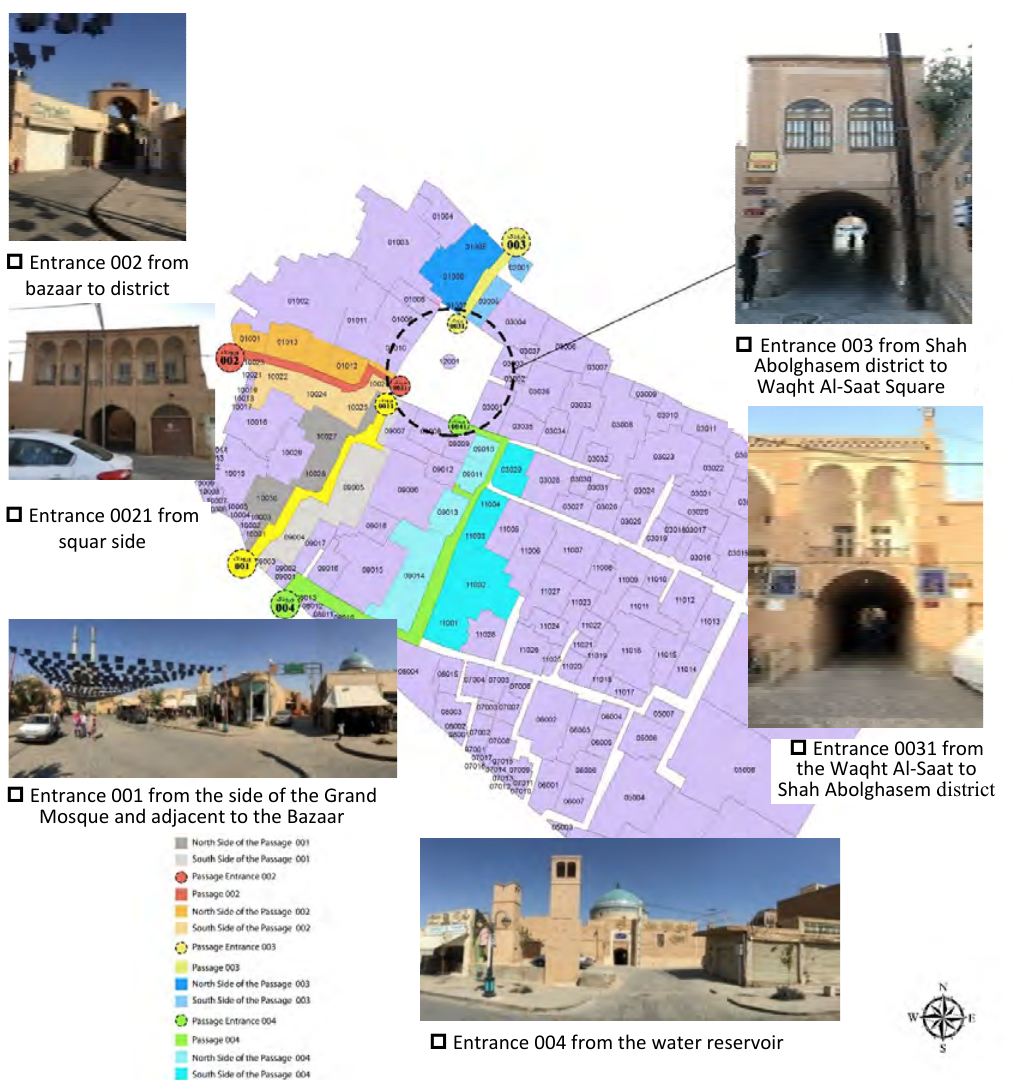
Fig. 10: Location of the square, passages, and main entrances of Waqht al-Saat district of Yazd